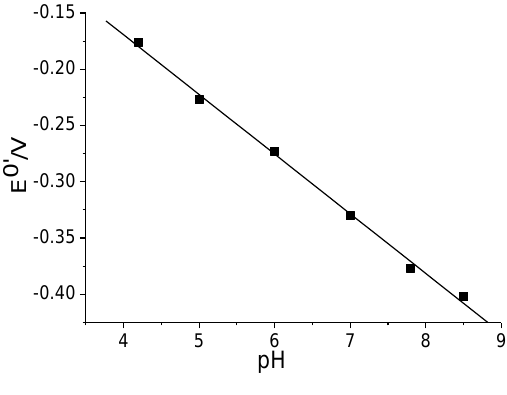
Figure 7. The dependence of E 0’ of the Hb/FDU-15 electrode on the solution pH.